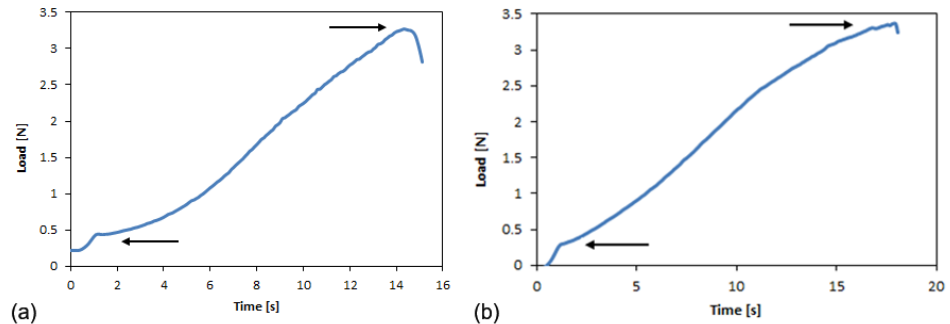
Figure 3. Load-time curves for L ( a ) and T ( b ) ETFE specimens: the points of the initial tear load and maximum load are indicated.